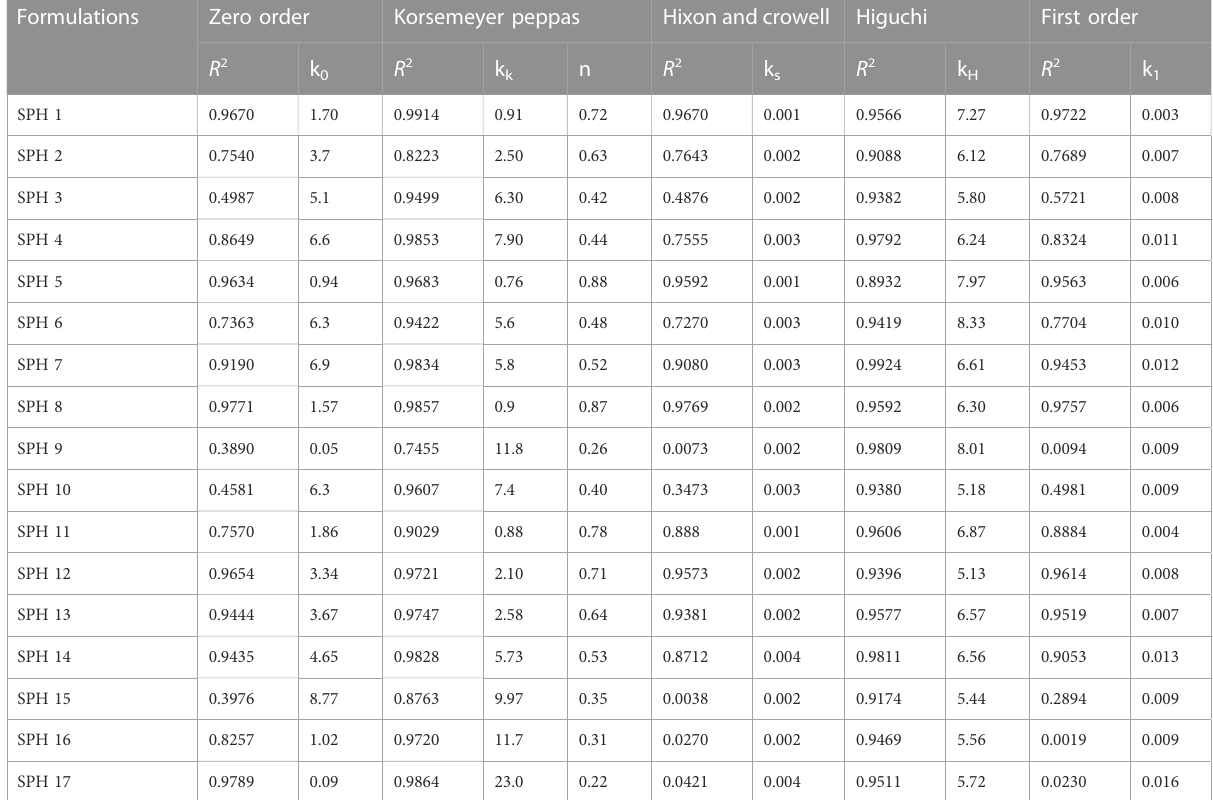
TABLE 6 Model dependent approach of superporous hydrogel formulations in phosphate buffer (pH 6.8).